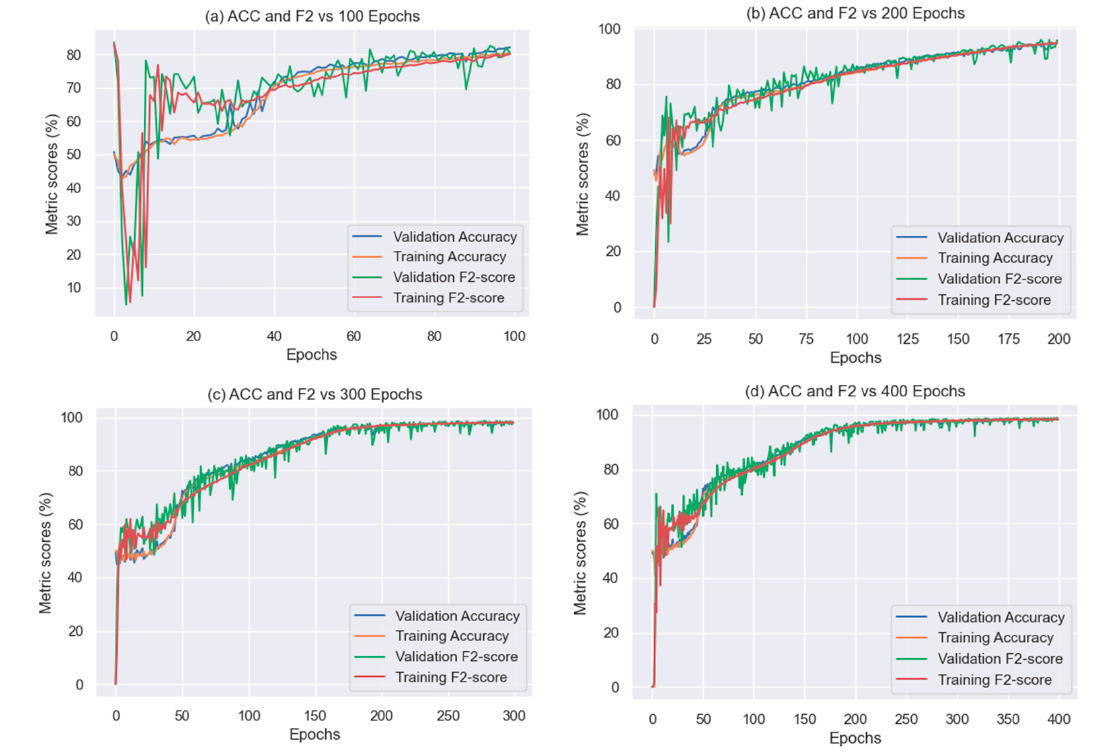
Figure 11. Accuracy and F2 ‐ score vs. epochs.